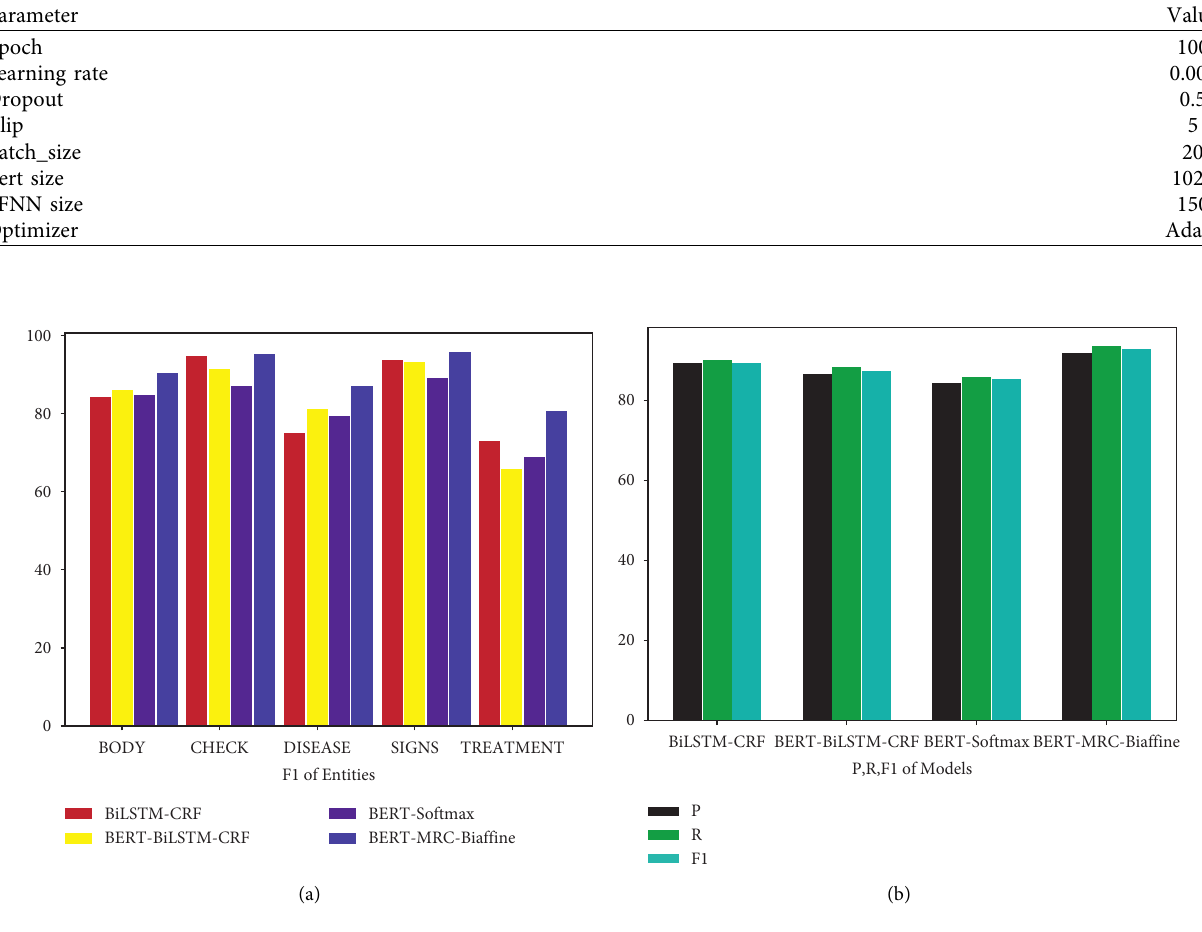
Figure 2: The performance comparison for entities and models. (a) F1 of entities. (b) P, R, and F1 of